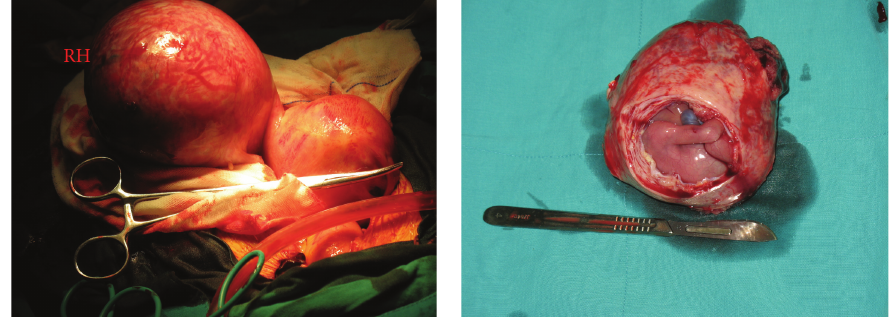
Figure 3: Intraoperative findings revealed a unicornuate uterus with left rudimentary horn